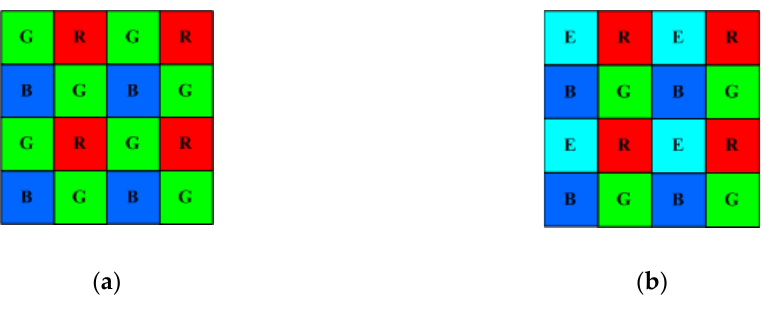
Figure 1. Schematic diagrams showing the ( a ) RGB color filter array and ( b ) RGBE color filter ar-